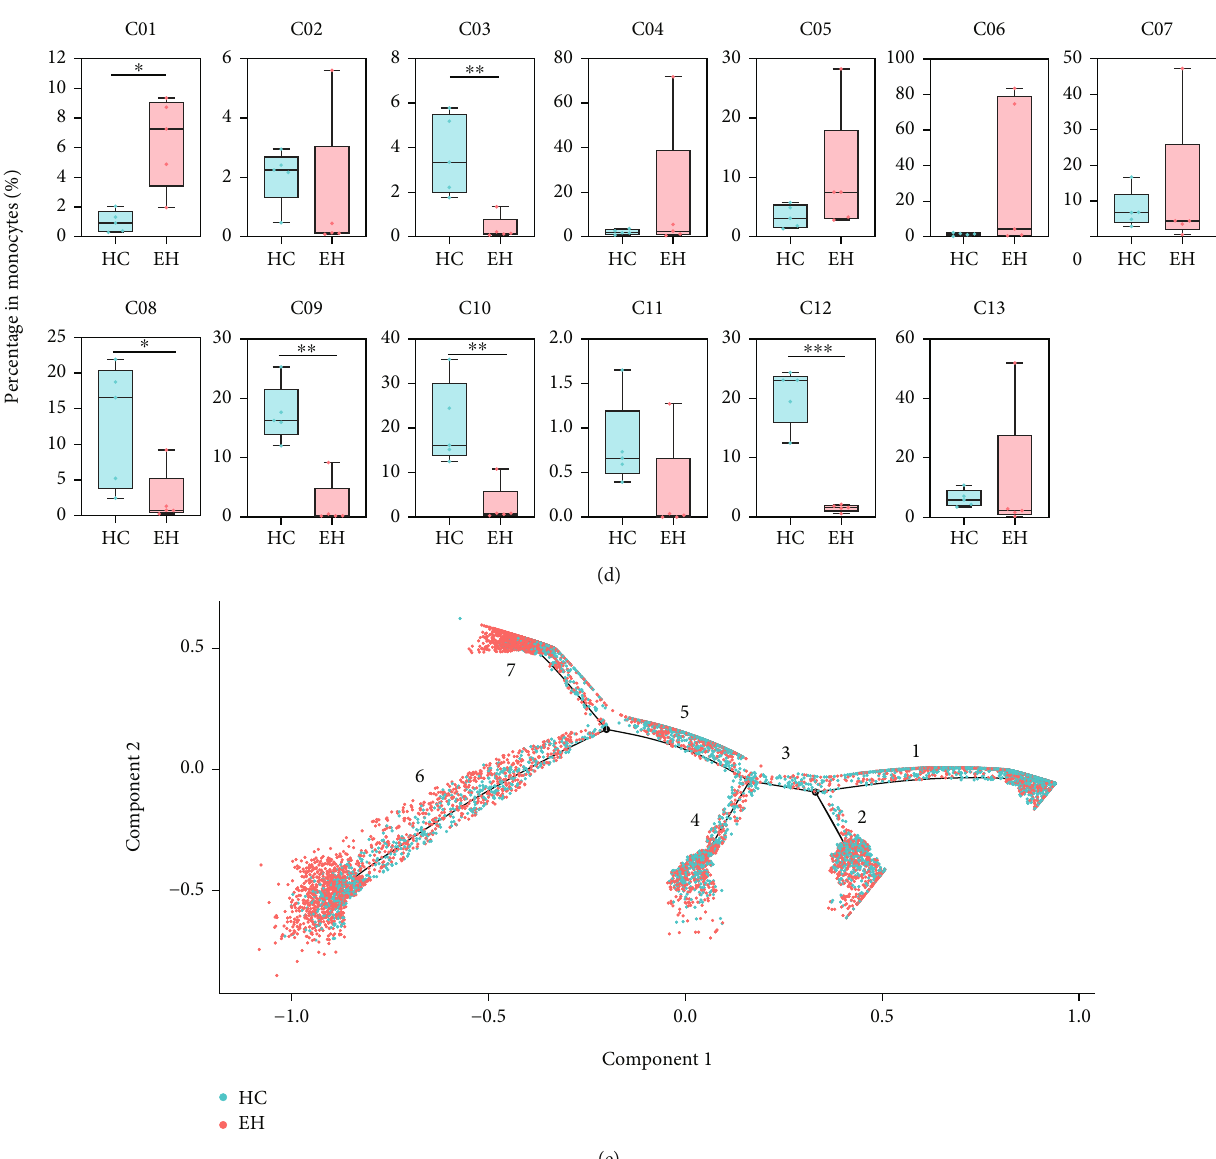
Figure 3: Di ff erence of monocytes between the HC and EH groups. (a) Second clustering analysis of monocytes (merge). (b) T-SNE plots of 13 monocyte subsets of the HC and EH groups. (c) The heat map of monocytes (merge). (d) Di ff erence in the percentage of monocyte subsets in HC and EH. (e) The plot of the pseudotime analysis for the HC and EH groups. There are 3 branch points and 7 branches in this picture. ∗ P < 0 : 05 , ∗∗ P < 0 : 01 , ∗∗∗ P < 0 : 001